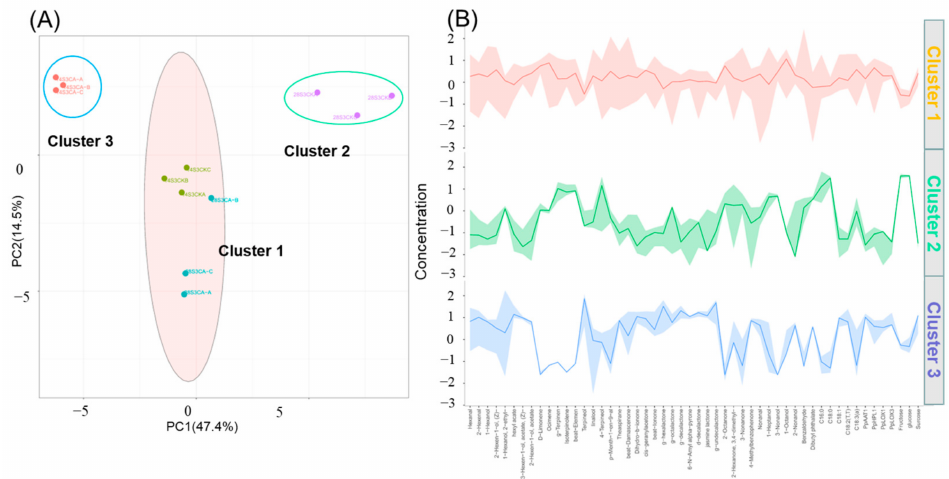
Figure 8. Cluster analysis of volatiles production, fatty acids, soluble sugars and genes expression during shelf-life after cold storage. ( A ) Cluster analysis of fruit samples; ( B ) Variation trend of characters involved in cluster. 28S3CK: the first number represents days after postharvest storage, S, means shelf-life, 3 means the days during shelf-life, the last letter means the biological